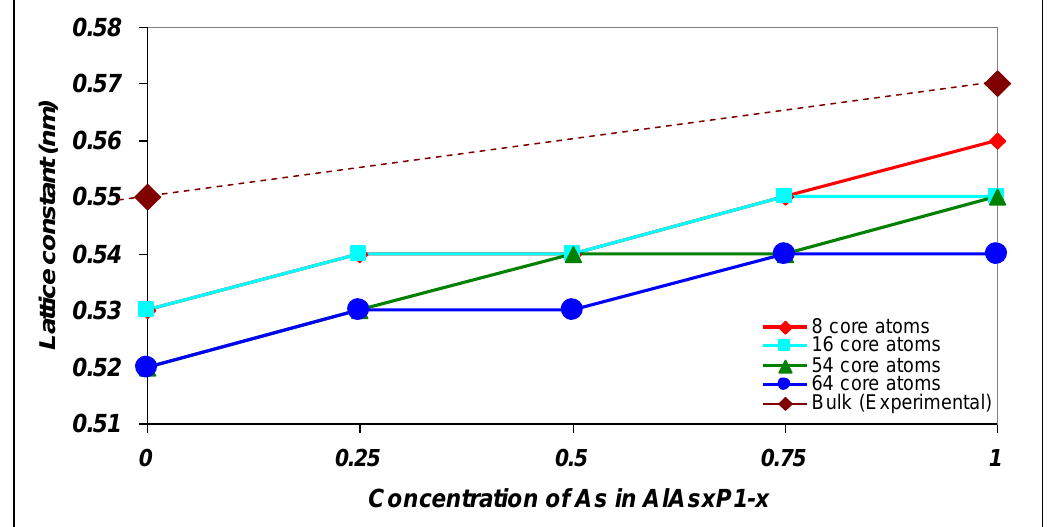
Fig.5: Lattice constant of Al As